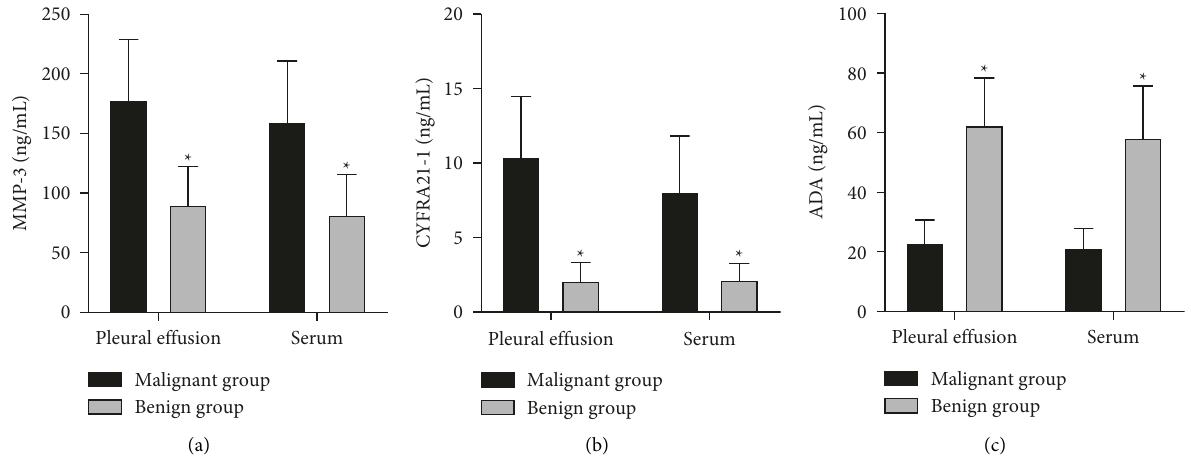
(a) Figure 1: Comparison of MMP-3, CYFRA21-1, and ADA levels in pleural effusion and serum. Compared with the malignant group, P 0.05. (a) represents a comparison of CXCL-13 levels; (b) represents a comparison of RBP-4 levels; and (c) represents a comparison of IL-6 levels. ∗ < Table 1: Comparison of positive detection rates of MMP-3, CYFRA21-1, and ADA in pleural effusion and serum. MMP-3 Groups Pleural effusion Serum Pleural effusion Malignant group ( n 44) (cid:31) Benign group ( n 75) (cid:31) χ 2 value